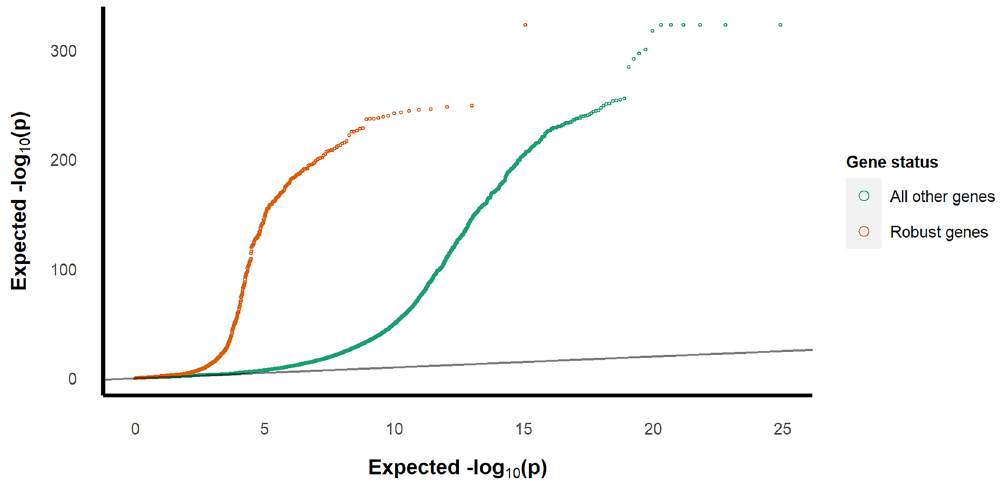
Figure 3. QQ-plot of p-value inflation. This figure shows the test statistic inflation for SNPs located in 12 genes with established DCM-associated variants compared to the remaining